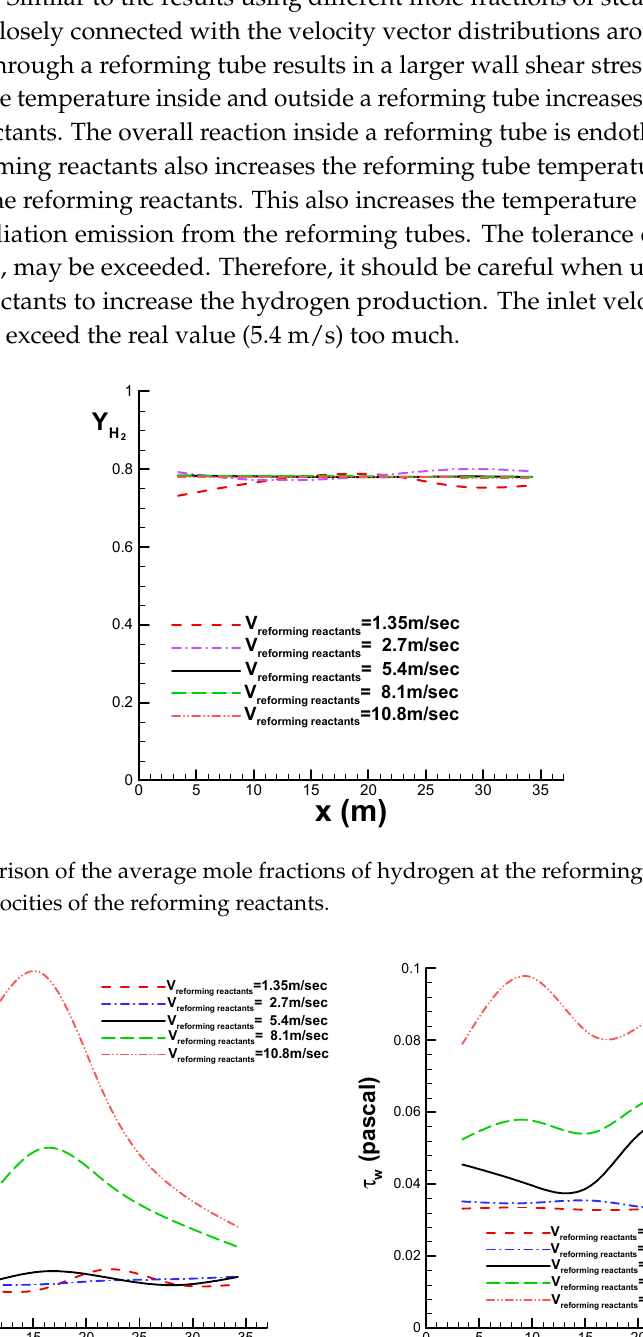
Figure 8. Comparison of the average temperatures at the surfaces of the reforming tubes using different inlet velocities of the reforming reactants.